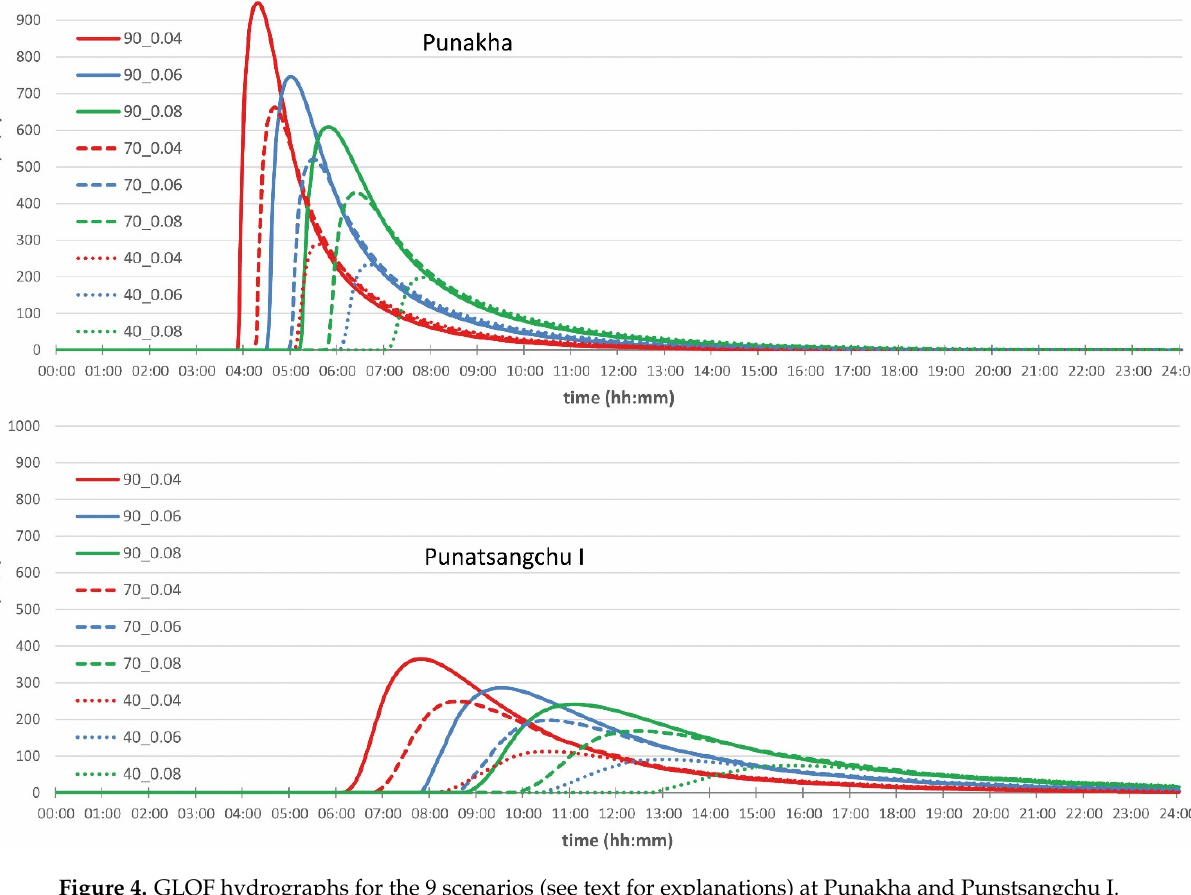
Figure 4. GLOF hydrographs for the 9 scenarios (see text for explanations) at Punakha and Punstsangchu I.